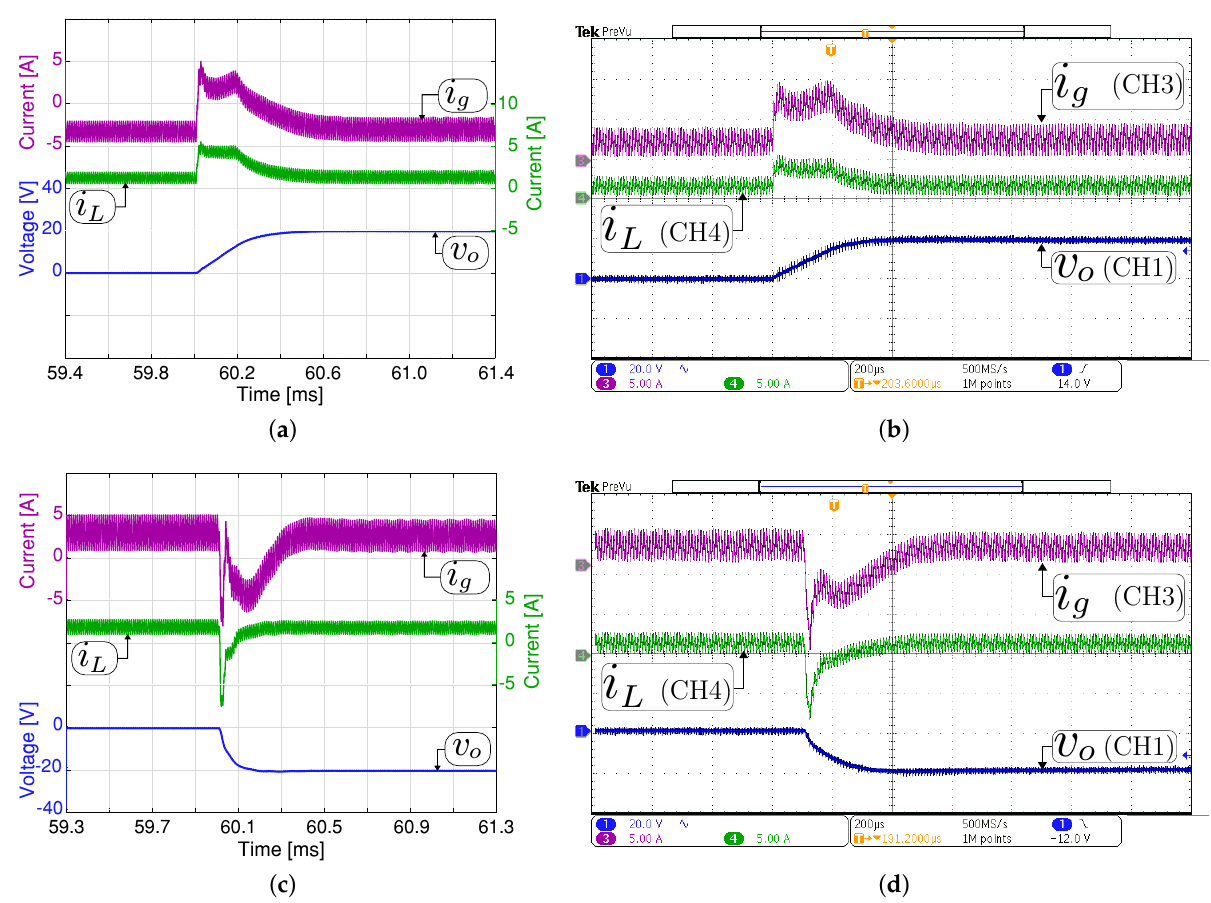
Figure 10. Large signal transient response with a constant resistive load R o = 200 Ω in boost mode ( V g = 200 V). Simulated ( a , c ) and experimental ( b , d ). Transient response when the output voltage reference changes from 294 to 314 V ( a , b ), and from 314 to 294 V ( c , d ). CH1: v o (20 Vac/div), CH3: i g (5 A/div), CH4: i L (5 A/div), and time base of 200 µ